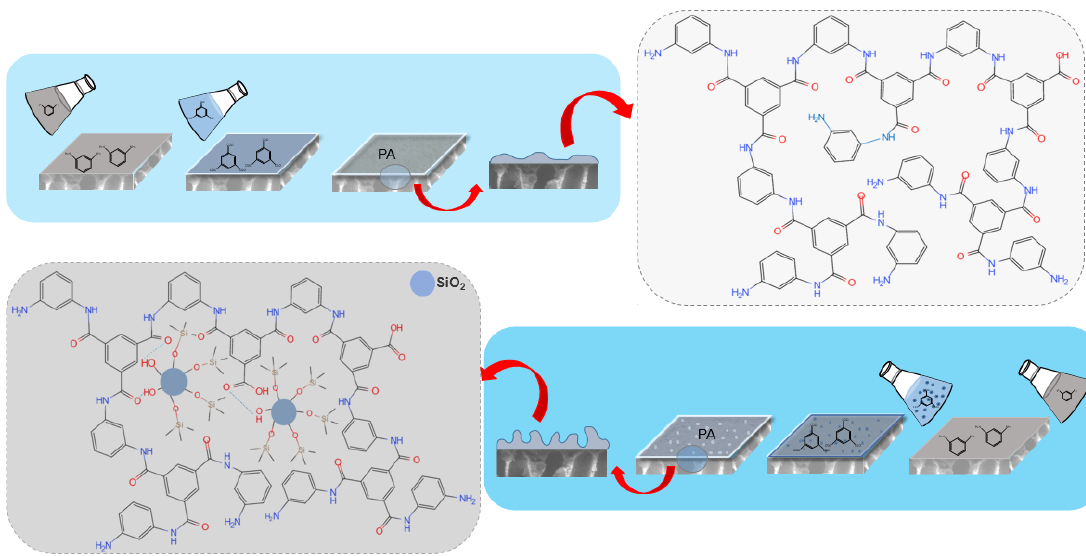
Figure 1. Fabrication progress and mechanism diagram for the TFC ( top ) and TFN ( bottom ) RO membranes. In the TFN-RO membrane, a significant amount of alkyl-silica NPs was imbedded in the membrane; hydrogen bonds were formed between the hydroxyl groups and amide-bonded oxygens while other branch chains of the alkyl-silica NPs were intertwined with the polymer matrix. Table 1. Basic parameters of the commercial hydrophobic NPs, as reported by the manufacturers.